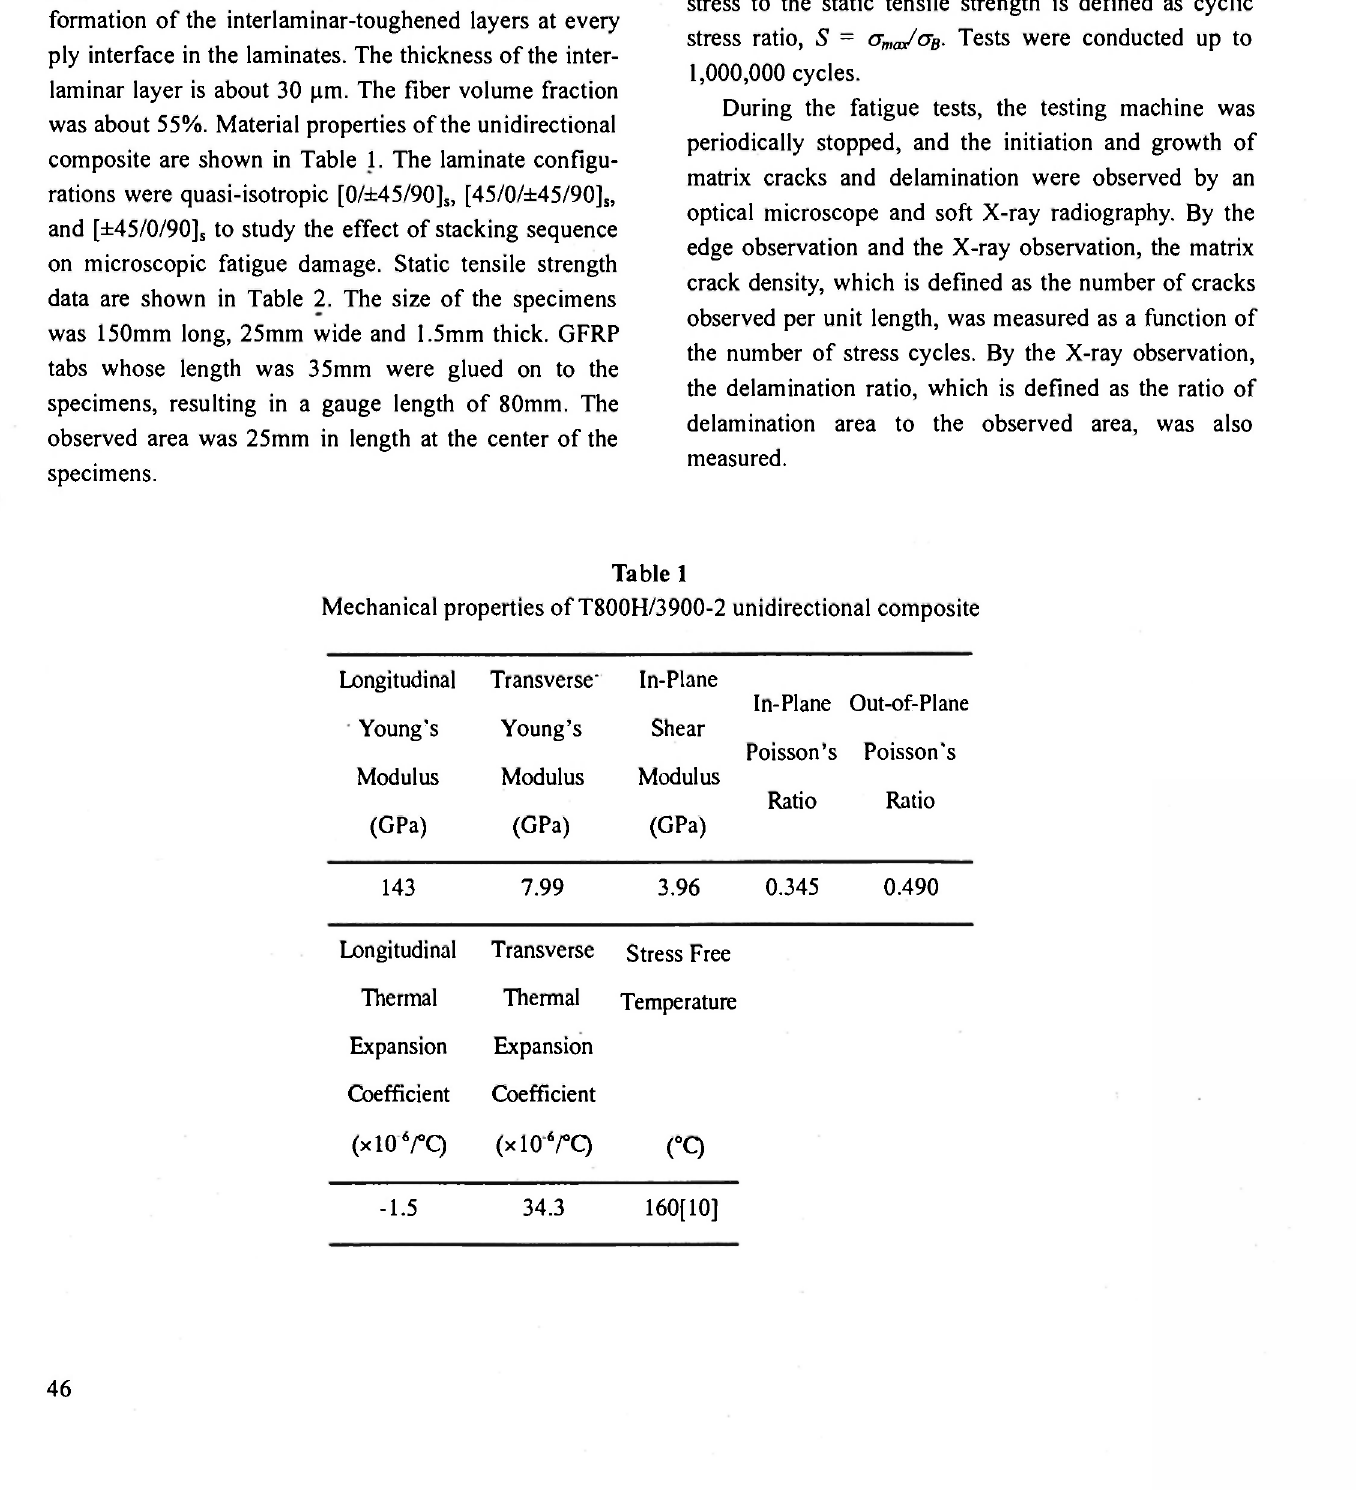
Mechanical properties of T800H/3900-2 unidirectional